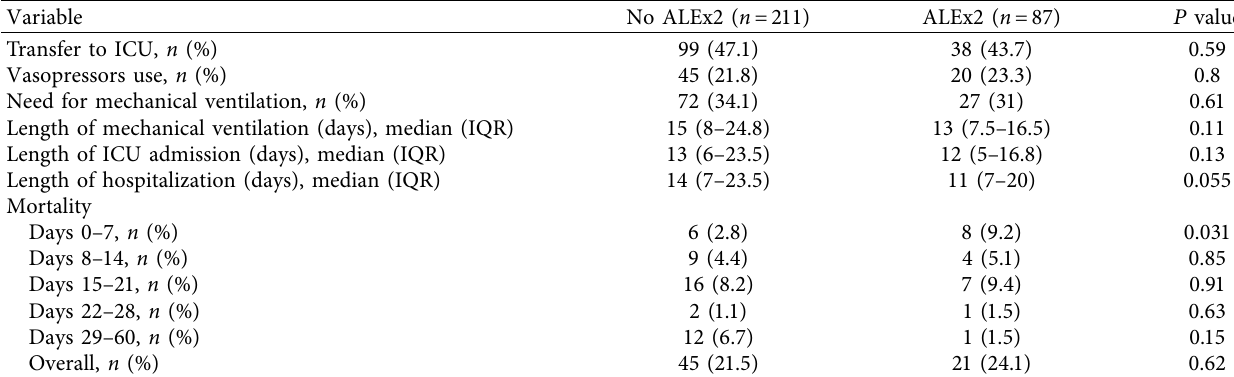
Table 2: Clinical course of patients hospitalized for